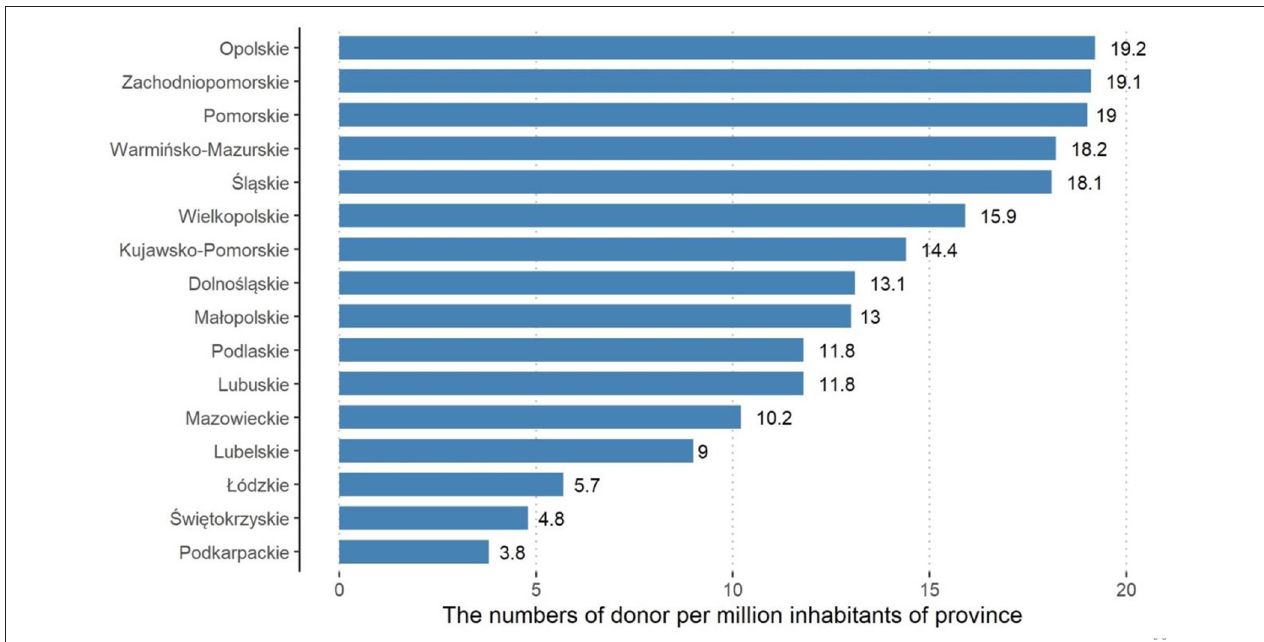
FIGURE 1 | Numbers of donors per one million inhabitants. Province, polish names of each voievodeship (2).